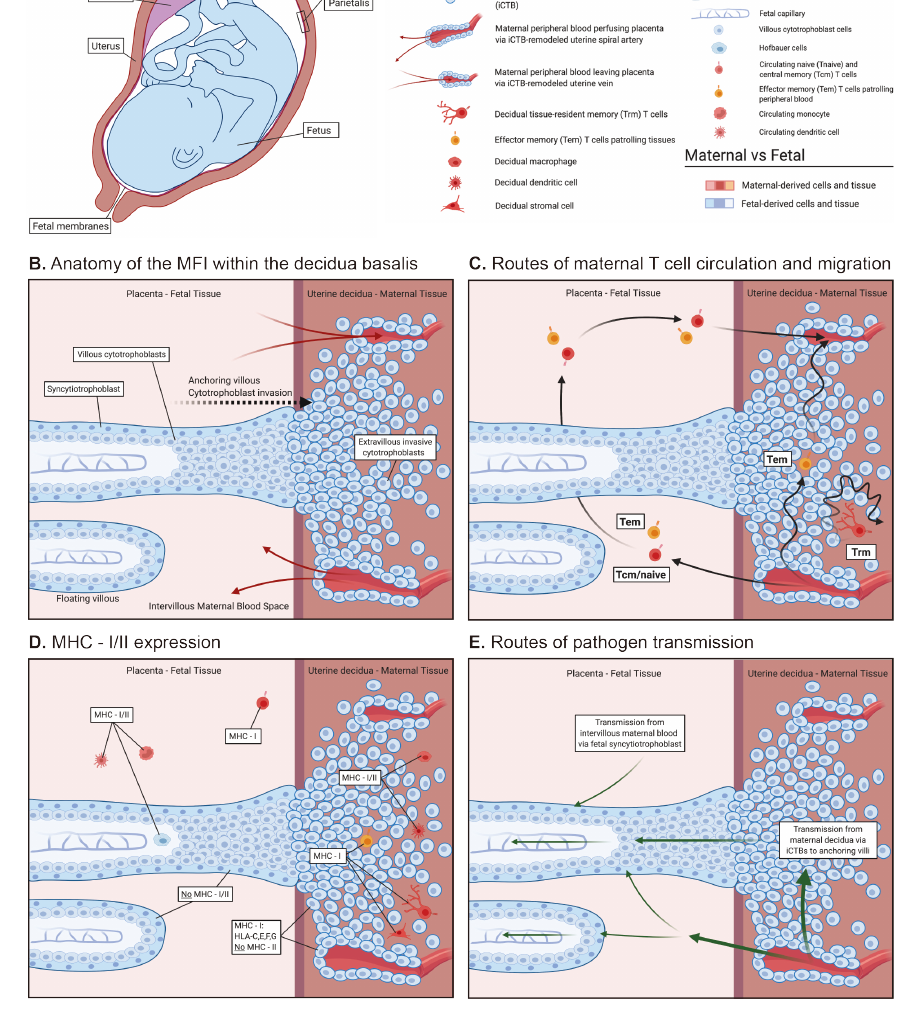
Figure 1. Gross and cellular anatomy of the maternal–fetal interface. ( A ) Gross anatomy of a fetus in utero. Placenta is colored purple to illustrate the maternal uterine (rose) and fetal (blue) tissues intermingling. The region where the placenta anchors to the uterus becomes the decidua basalis; where the fetal membranes contact the remaining surface of the uterus is the decidua parietalis. ( B ) Basic cellular anatomy of the maternal–fetal interface illustrating the fetal cells of the placenta (blue) invading the uterus (rose) and the maternal peripheral blood (light rose) bathing the placental villi. ( C ) Di ff erent maternal T cell populations patrolling complementary regions for antigen; intervillous blood space versus decidua. Black arrows indicate routes of surveillance. ( D ) Varied MHC-I and -II expression by maternal and fetal cells. ( E ) Possible routes of pathogen transmission (green arrows) from mother to fetus. Figure created with